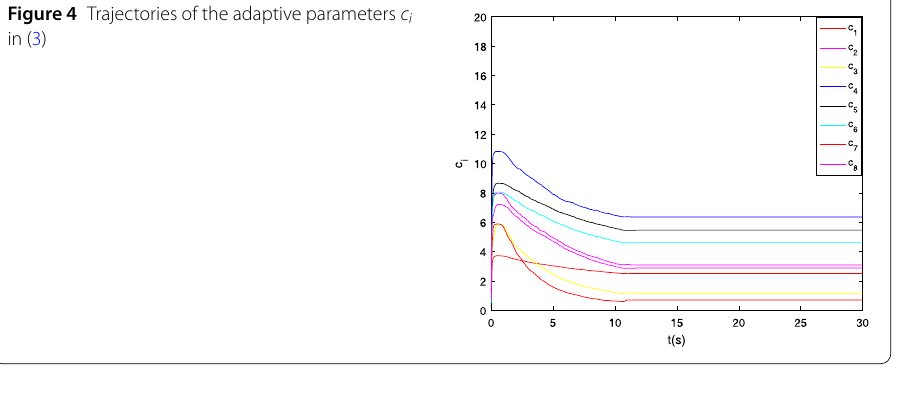
Figure 5 Trajectories of x i 1 under leader-following synchronization protocol